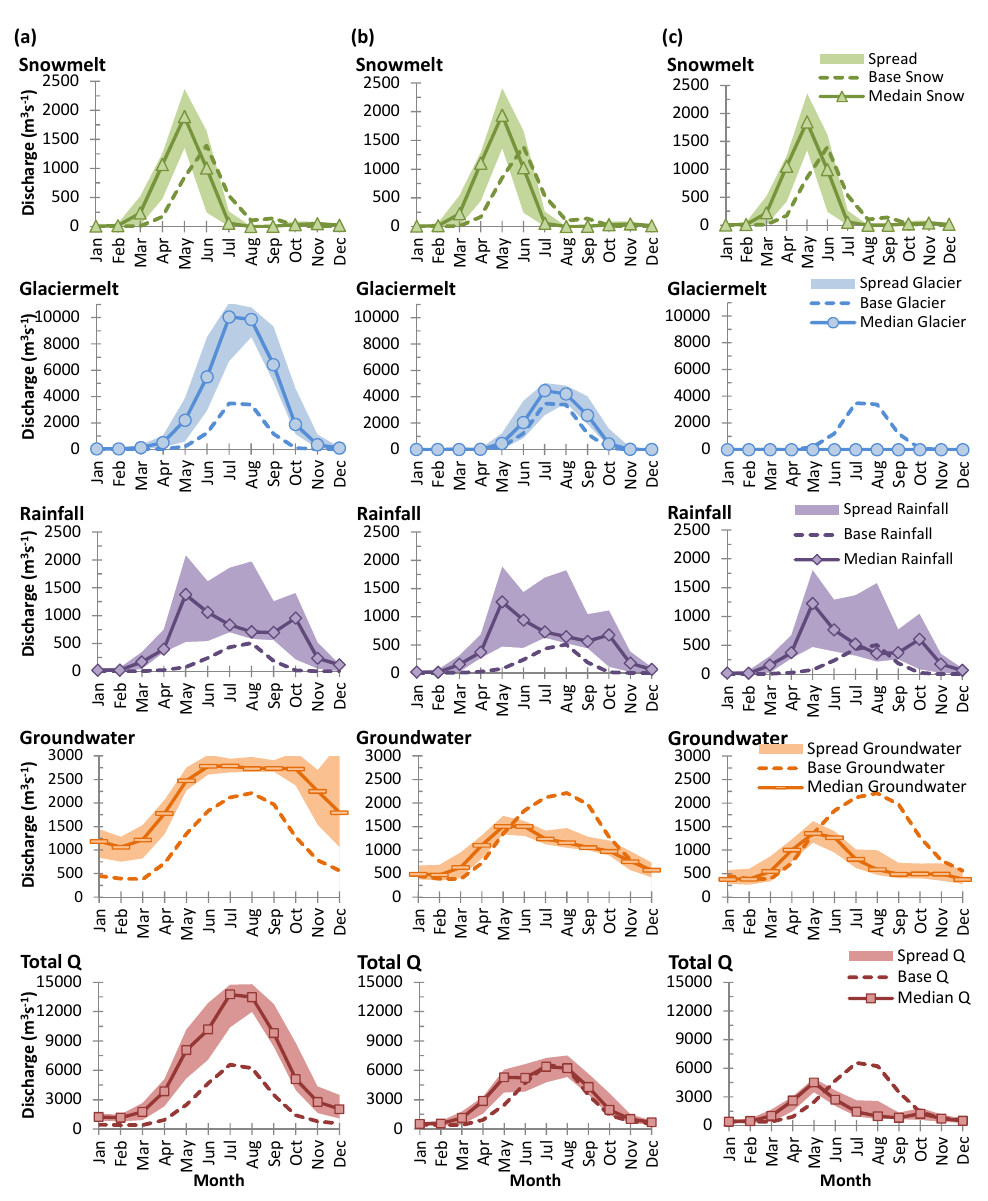
Figure 9. Results of far-future climate change scenario as projected by seven (low fidelity) CORDEX-SA regional climate modeling experiments under the representative concentration pathway (RCP)